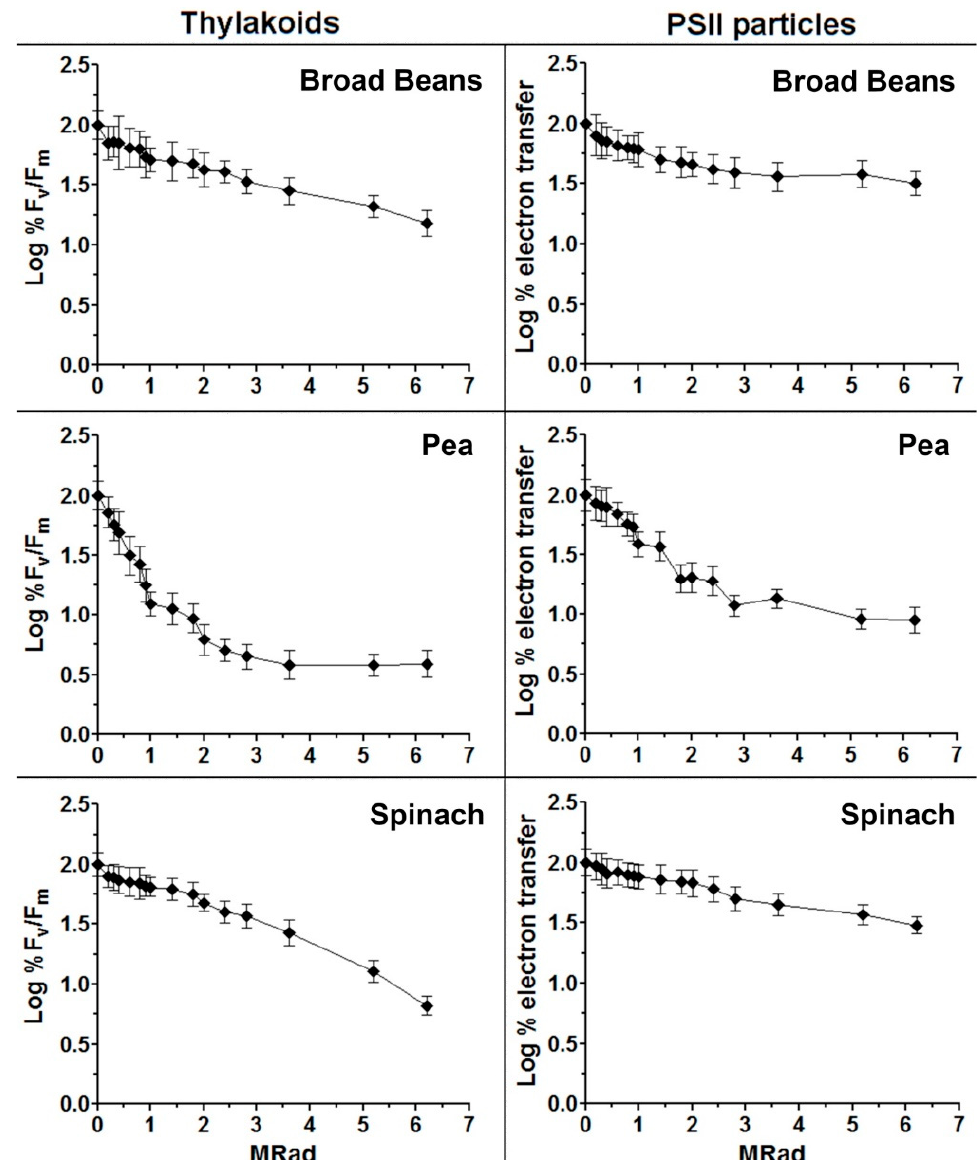
Figure 5. Radiation target analyses of thylakoids and photosystem II (PSII) particles isolated from broad bean, pea and spinach plant species. Initial PSII activity of the controls before irradiation averaged 0.856 ± 0.005 for fluorescence F v /F m ratio, and 300 ± 28 μ mol 2,6-dichlorophenolindophenol reduced per mg of chlorophyll h − 1 for electron transfer activities. Each point is the mean of three measurements. The experiments were repeated at least five times using independent preparations for each species.